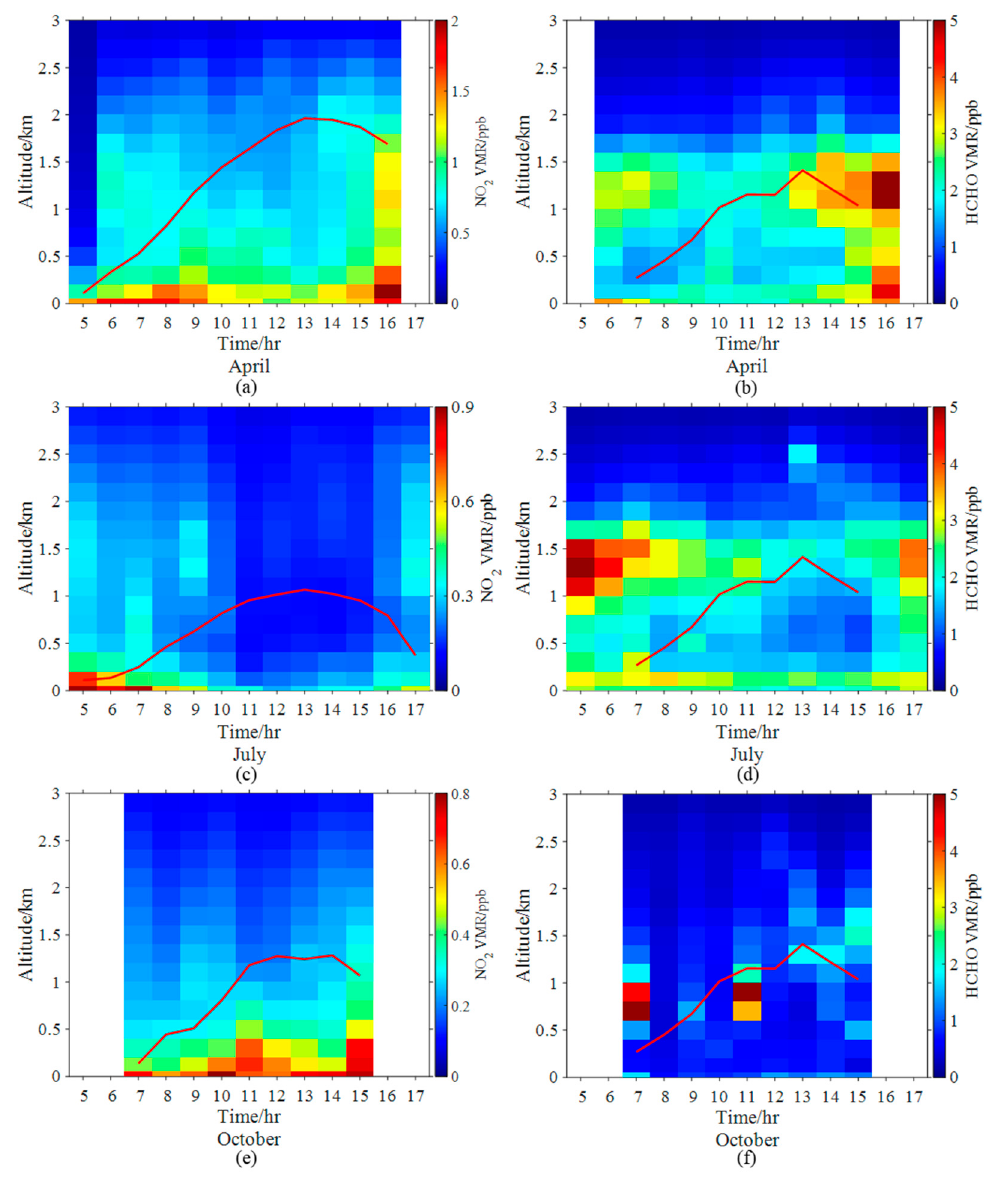
Figure 6. Diurnal variations of the vertical profile of NO 2 in April ( a ), July ( c ) and October ( e ). ( b , d , f ) Same as ( a , c , e ) correspondingly, but for HCHO. The red line indicates the planetary boundary layer height (PBLH).